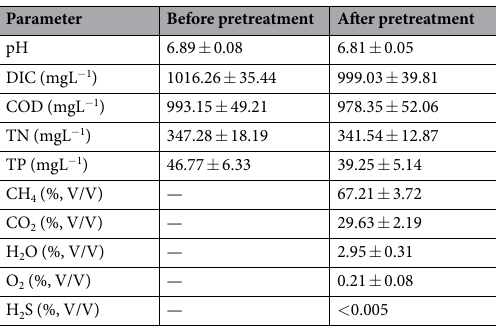
— < 0.005 Table 5. The characteristics of biogas slurry and crude